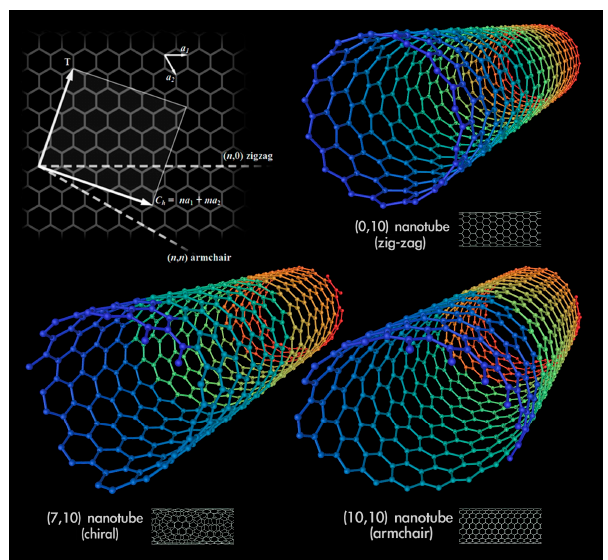
Figure 5. The three types of SWCNTs (adapted from [138]).